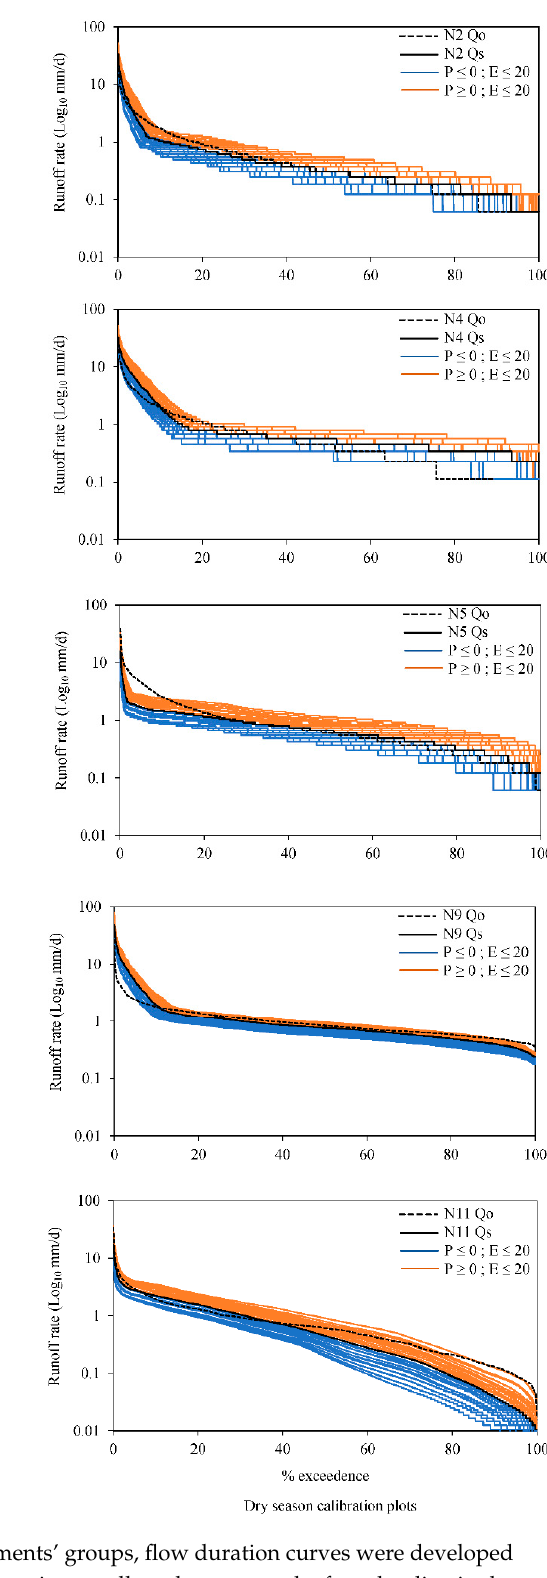
Figure 4. Flow duration curves on the four catchments’ groups, flow duration curves were developed using daily data (i.e., additional supporting information on all catchments can be found online in the Supporting Information section at the end of the paper, Figure S3).